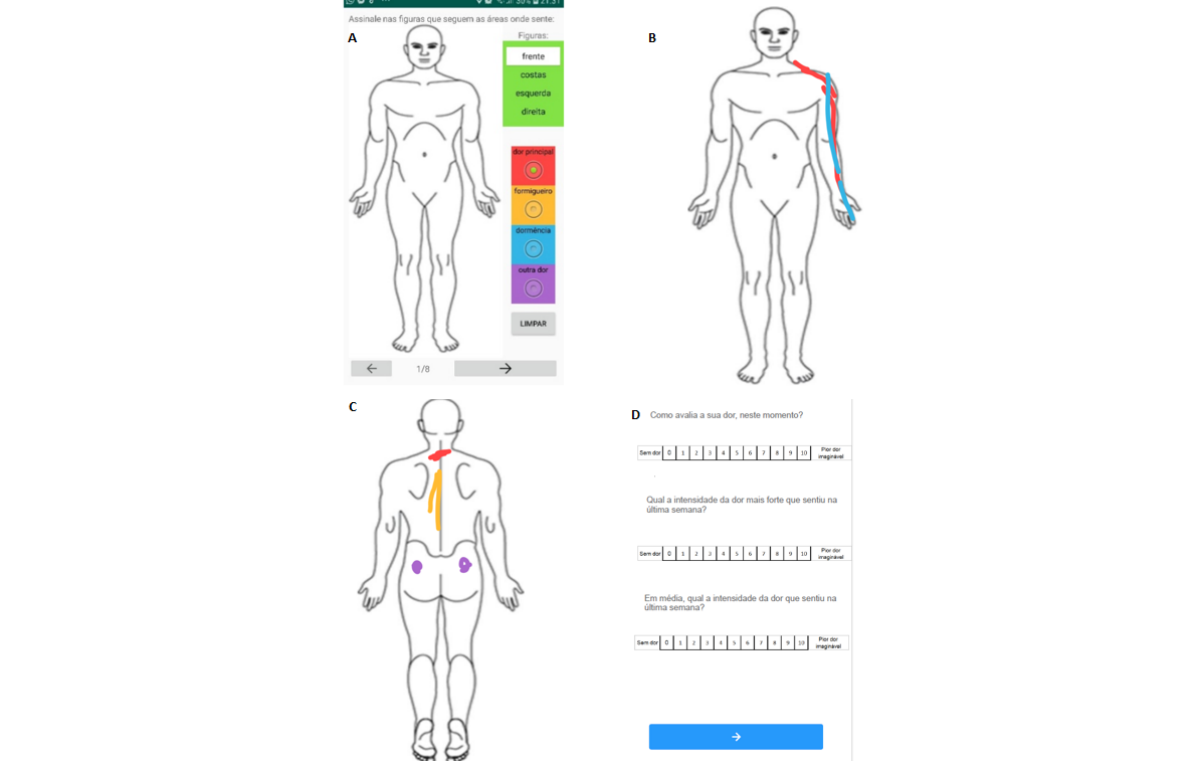
Table 4. Summary of physiotherapists’and patients’comments on the first version of the AvaliaDor app. Physiotherapists (Samsung Galaxy S7; Samsung Galaxy S6; Huawei P10 Lite; Huawei P20)